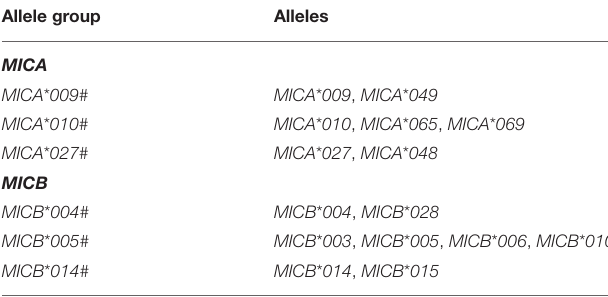
TABLE 1 | Overview of ambiguous genotyping results.